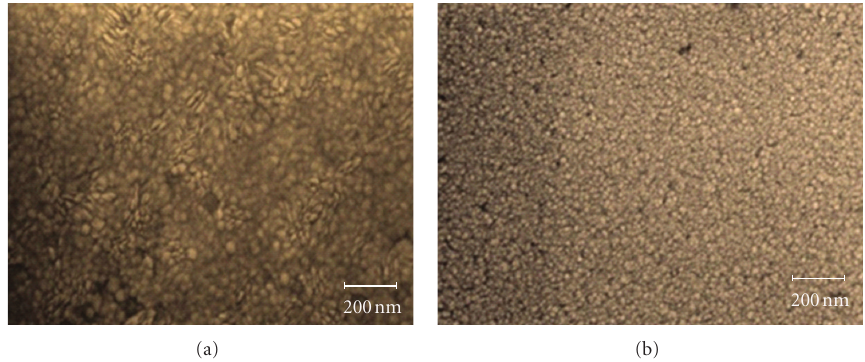
Figure 3: Scanning electron micrographs of (a) commercial and (b) RF-sputtered ITO thin films.